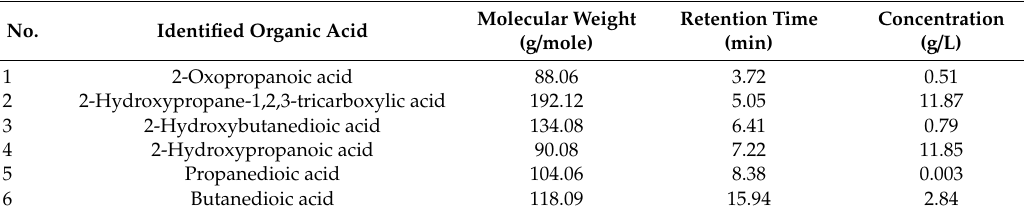
Table 2. Acid profile of L. coryniformis BCH-4 AMCs with their respective molecular weight, retention time and concentration.